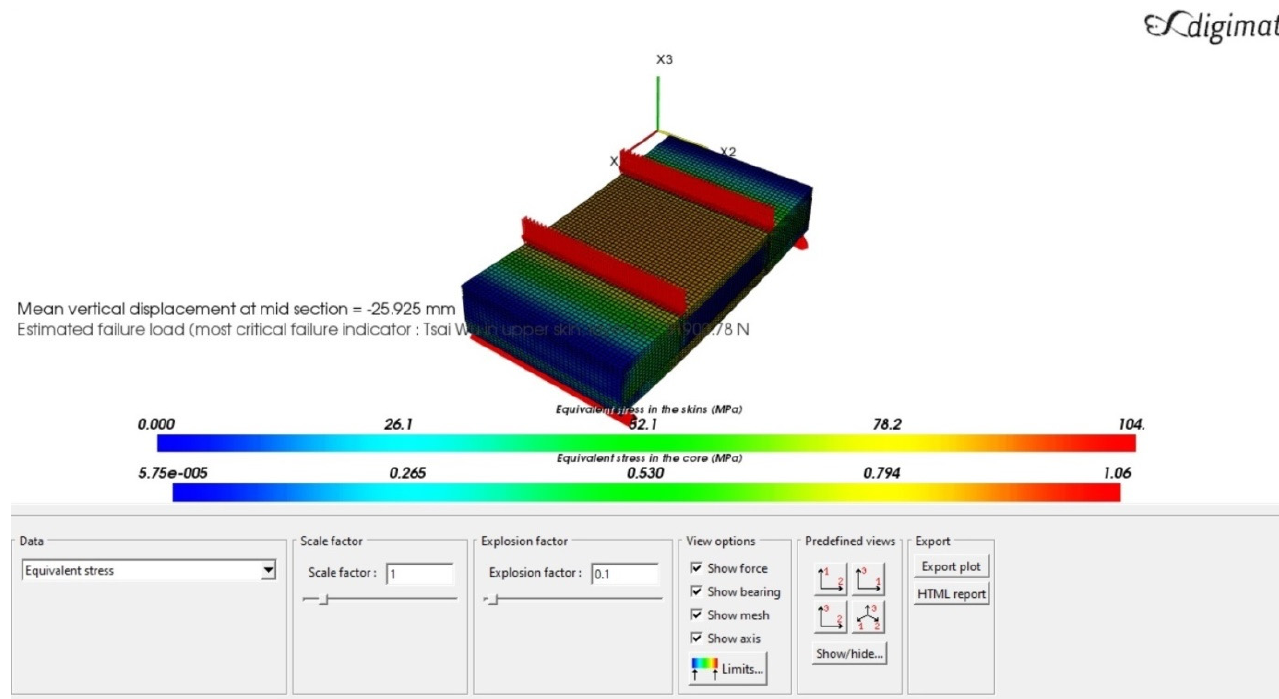
Figure A1. The four-point bending test for the sandwich plate of the helicopter floor numerical model. FRP honeycomb core ( t c = 136 mm) and woven glass fiber with phenolic resin face sheets ( t f = 1 mm).